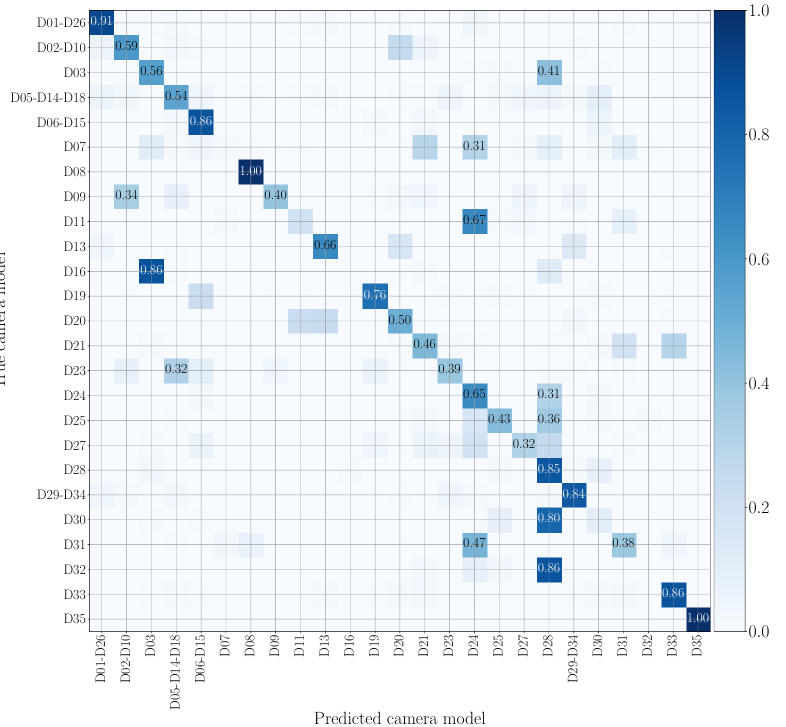
Figure 9. Confusion matrix achieved by mono-modal camera model identification, exploiting audio patches only. We report results by training on the native video set and testing on the WhatsApp set, and we only show the numbers that exceed 0.3. The device nomenclature is that of [44].